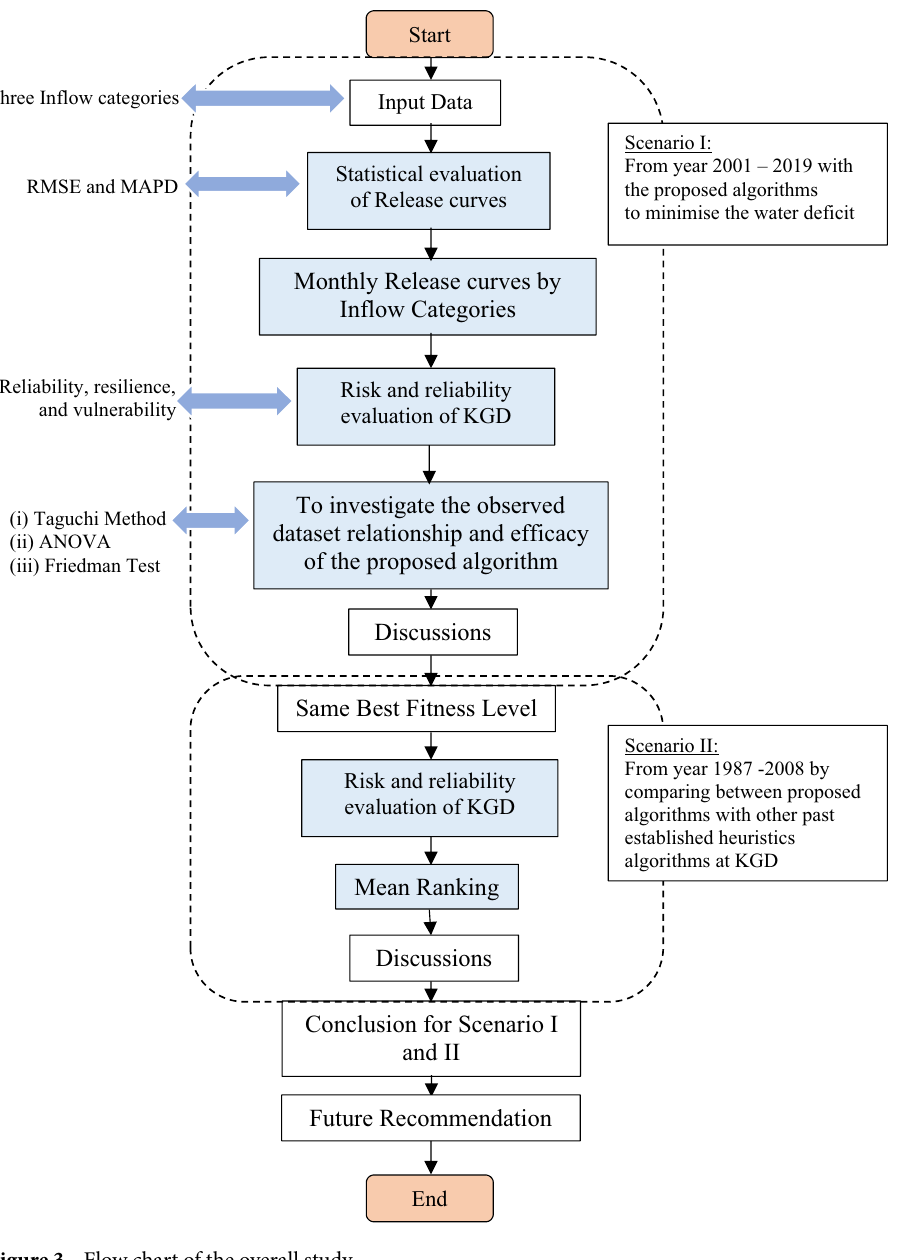
Figure 3. Flow chart of the overall